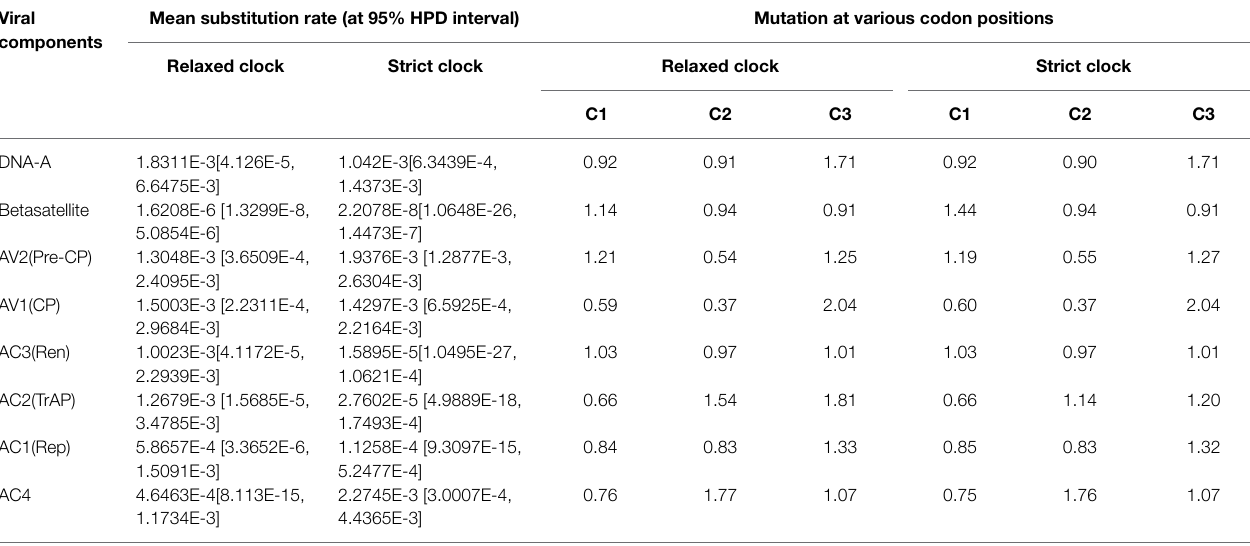
TABLE 5 | Estimation of Mean Substitution and Codon Degeneracy Rates for DNA-A, ORFs, and betasatellite associated with PaLCD in India. Viral Mean substitution rate (at 95% HPD interval) Mutation at various codon positions components